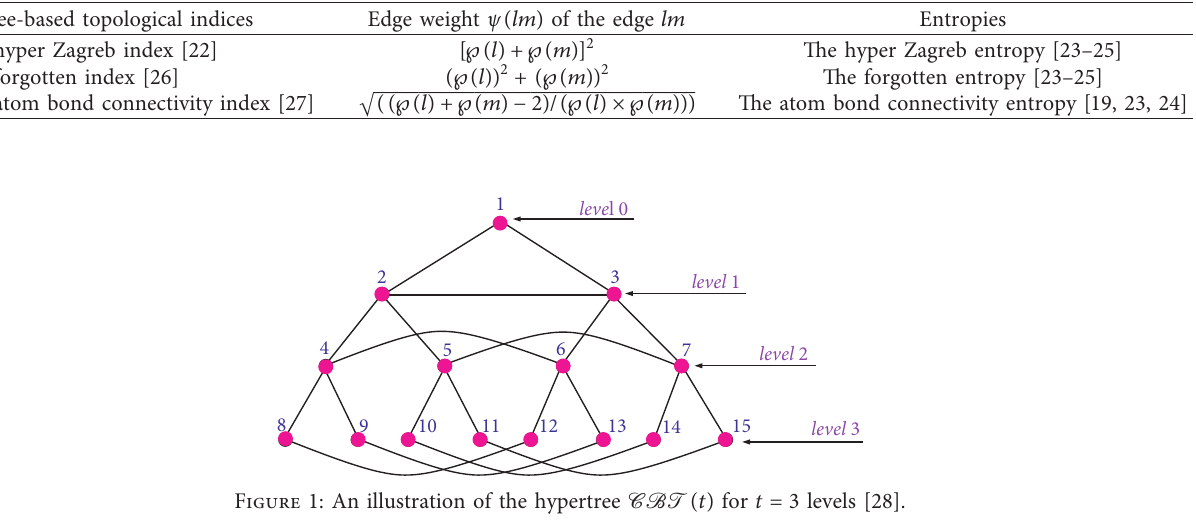
Table 2: Degree-based topological indices along with their respective edge weight ψ ( lm ) of the edge lm .